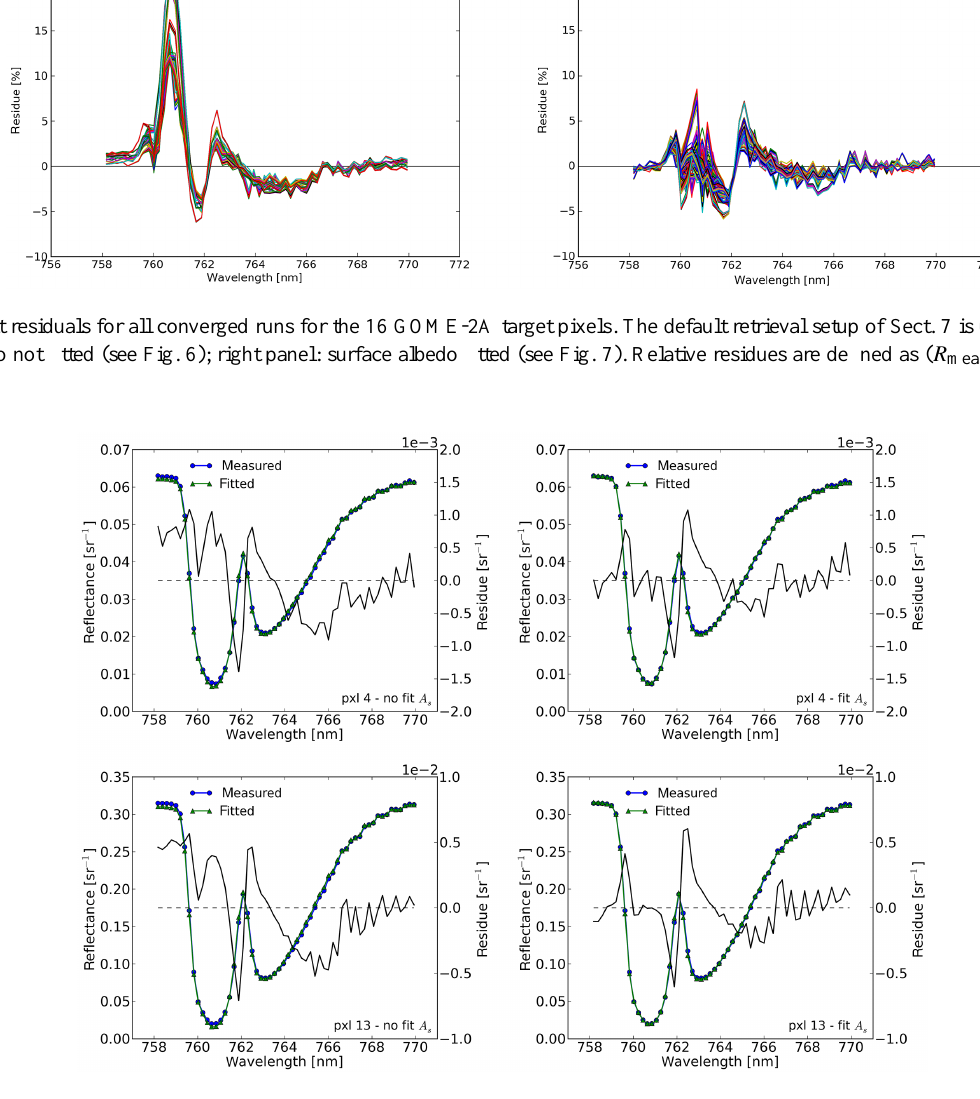
emission is typically spectrally smooth and here allowed to depend linearly on wavelength across our fit